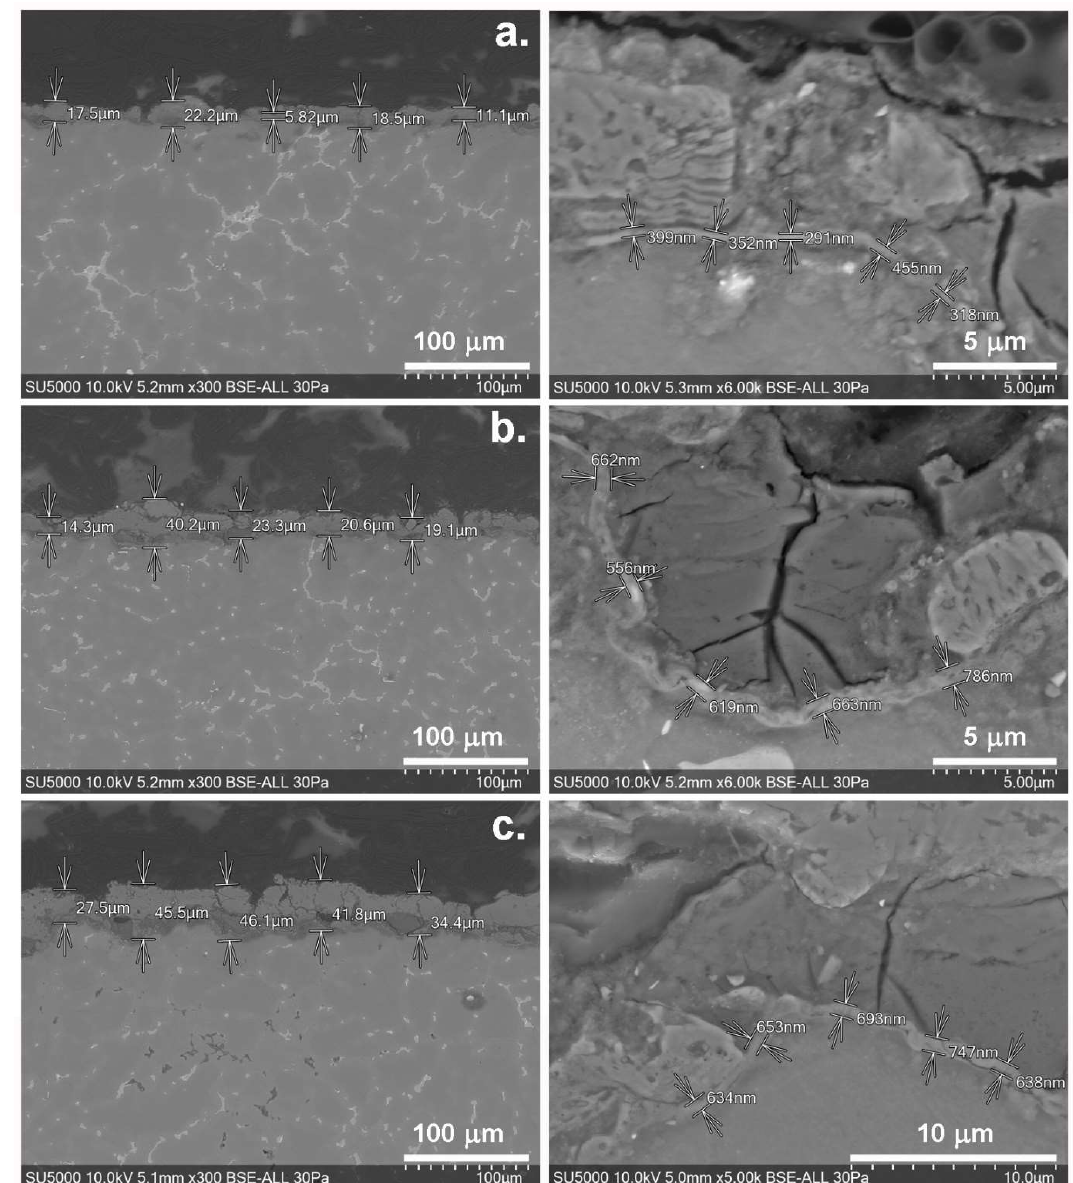
Figure 8. Overall coatings ( left ) and barrier layer ( right ) thickness of AZ63_5m ( a ), AZ63_10m ( b ) and AZ63_20m ( c ) samples.